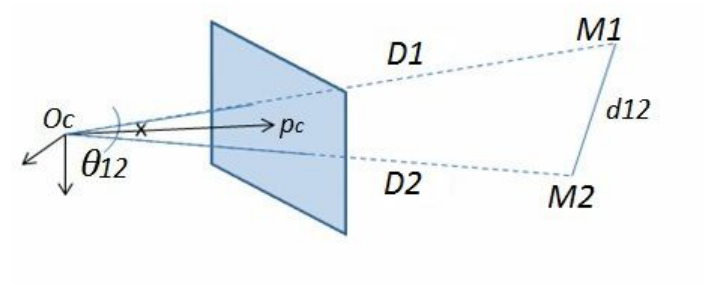
Figure 5. The triangle formed by M 1 , M 2 (3D points in the camera frame) and O d is the Euclidean distance between M 1 and M 2 that is supposed to be known, and D 12 D are their depths relative to O 2